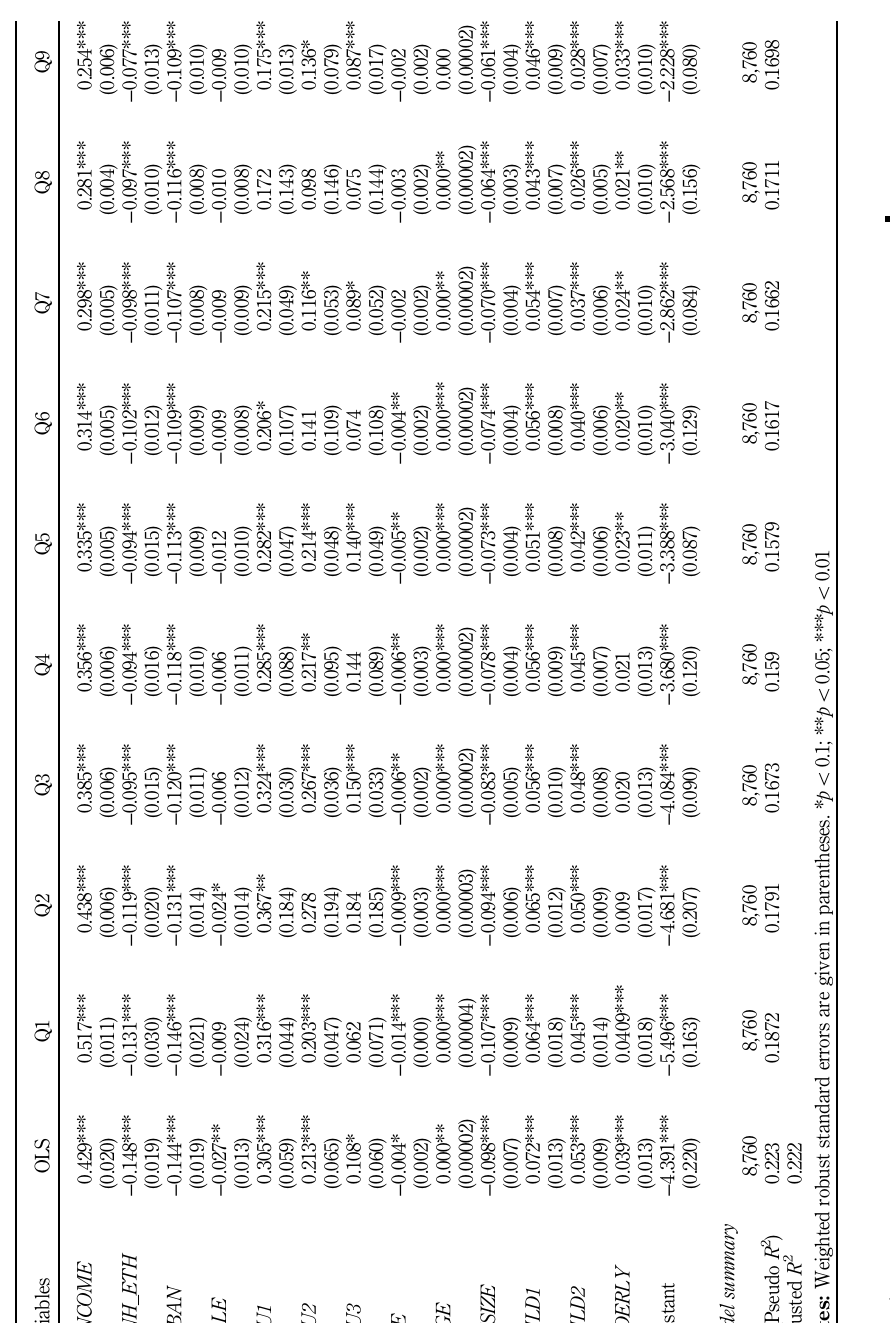
Table II. The effects